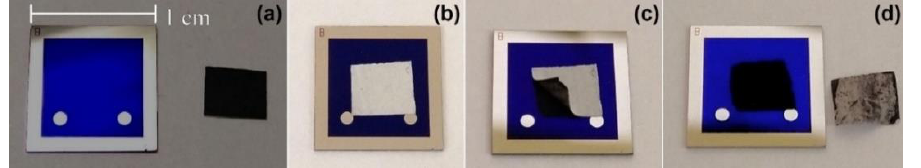
Figure 2. Phases of the dry transfer process. ( a ) Substrate and piece of SWCNT filter before the transfer. ( b ) SWCNT film pressed over the substrate surface after wetting it with water and ethanol.